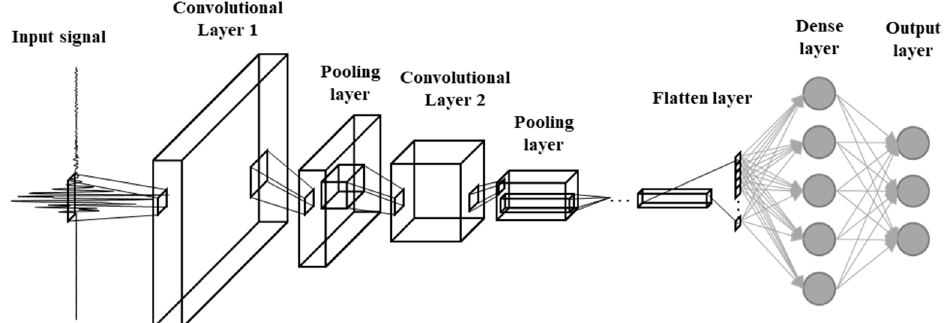
Figure 7. Architecture of the convolutional neural network.